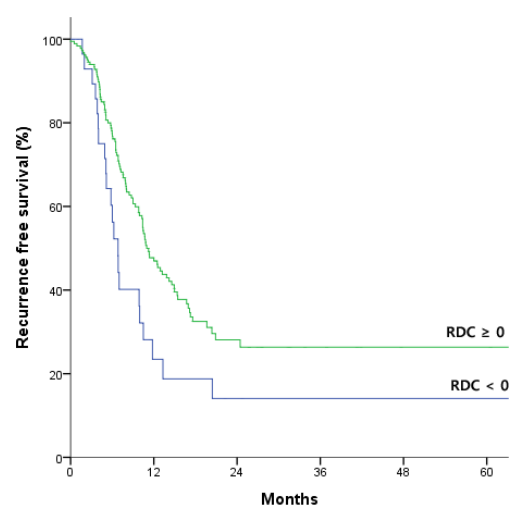
Figure 1. Kaplan-Meier analysis of recurrence free survival in patients with relative difference of carbohydrate antigen 19-9 (RDC) ≥ 0 and < 0. Median recurrence free survival was significantly longer in patients with RDC ≥ 0 than in those with RDC < 0 (10.9 vs. 6.8 months; p = 0.016 by log-rank test).